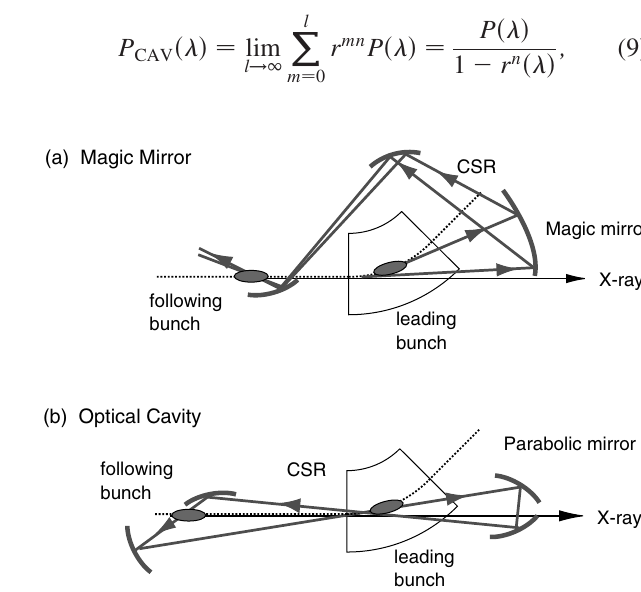
FIG. 2. Schematic drawing of the optics for inverse Compton